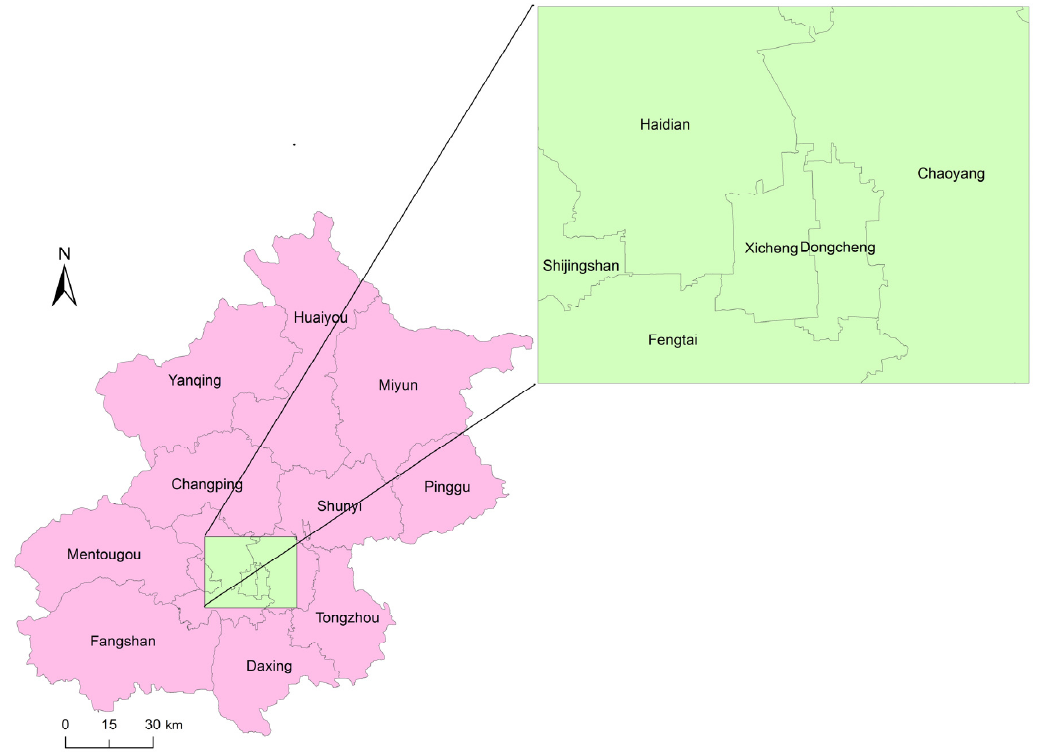
Figure 1. Study area in Beijing, denoted by a green rectangle.